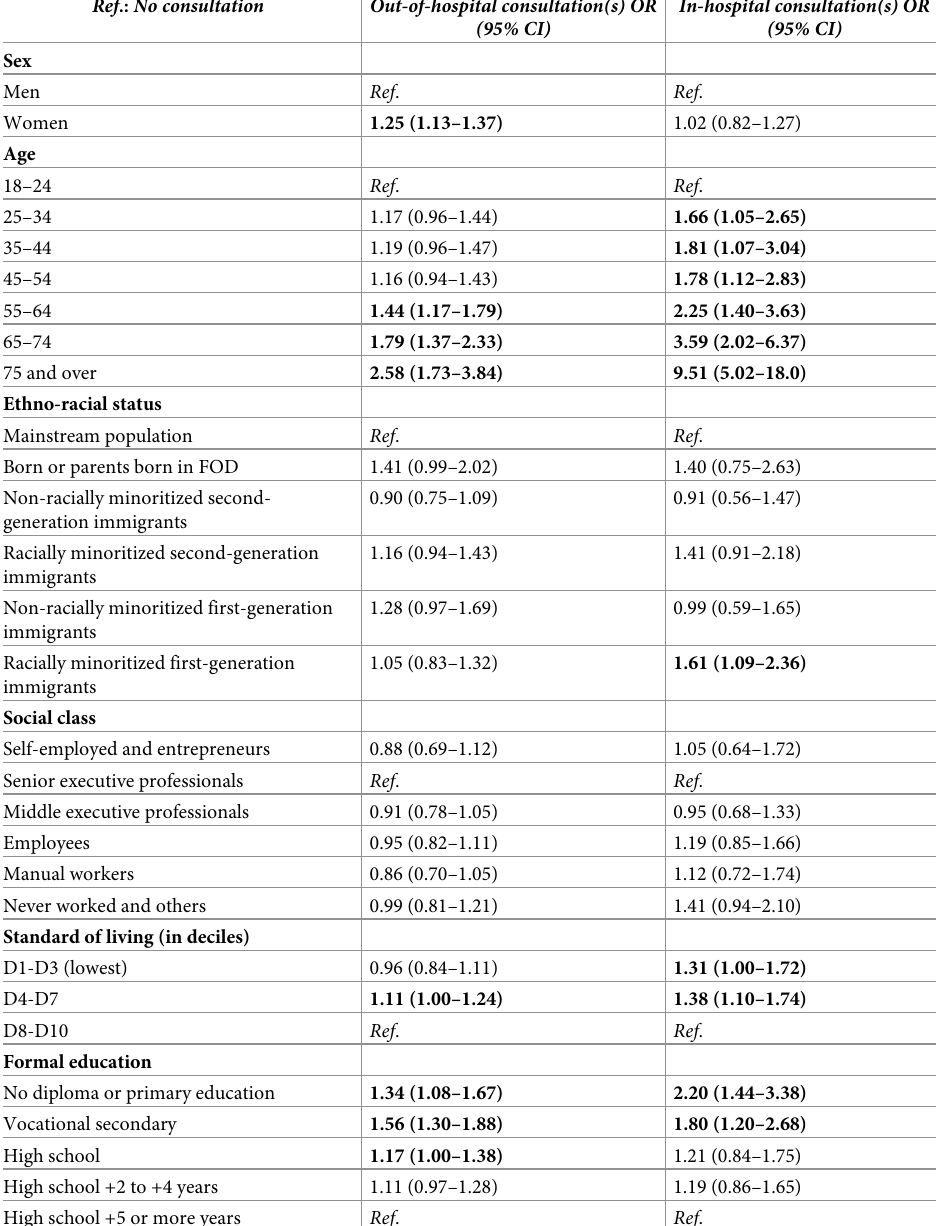
Table 3. Factors associated with use of health care services (multinomial regression, reference = no